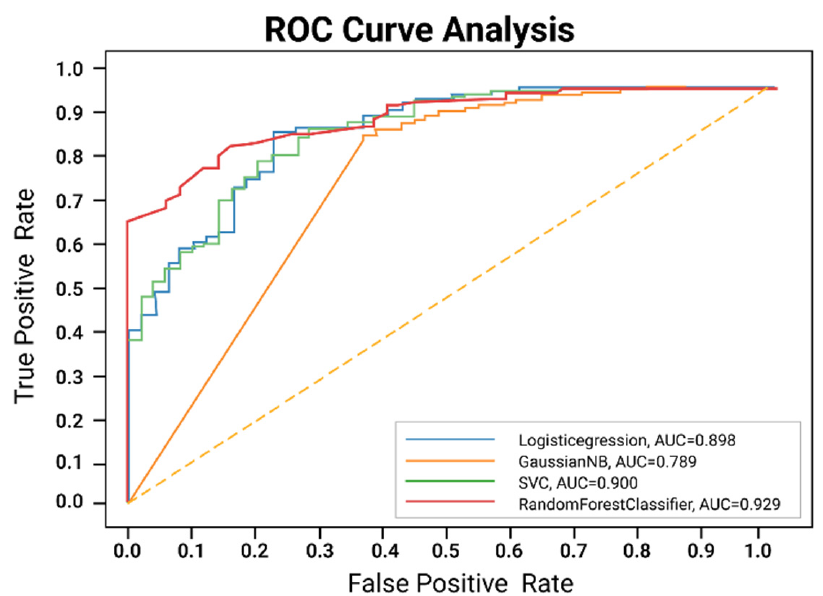
Figure 4. Proposed model with autoencoder ROC curve.